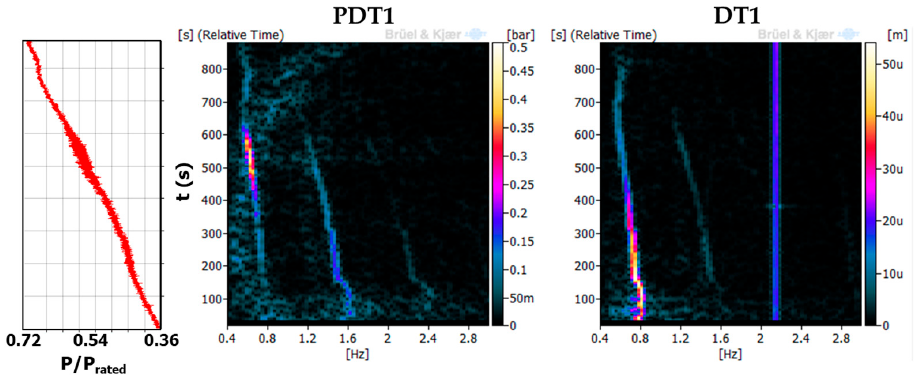
Figure 9. Time-frequency of the pressure in the draft tube (PDT1) and the displacement probe in the shaft (DT1) for the part load operation.